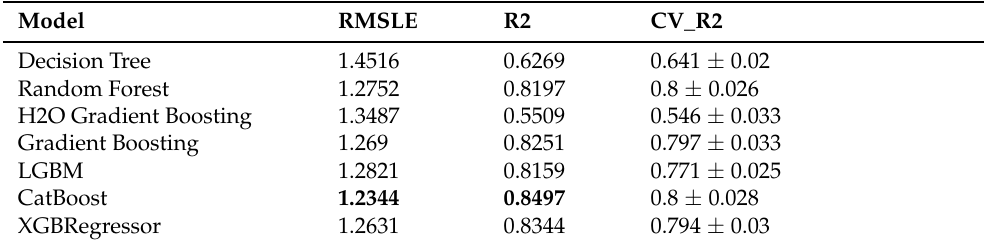
Table 5. ML regression models